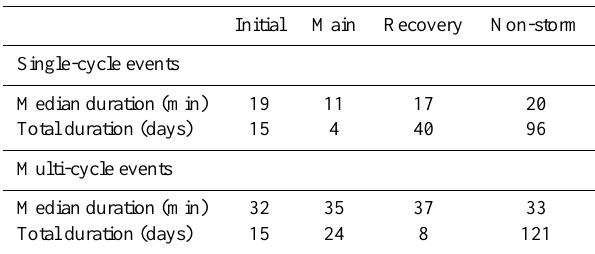
Table 7. Median values of substorm recovery phase durations of single and multi-cycle substorms.